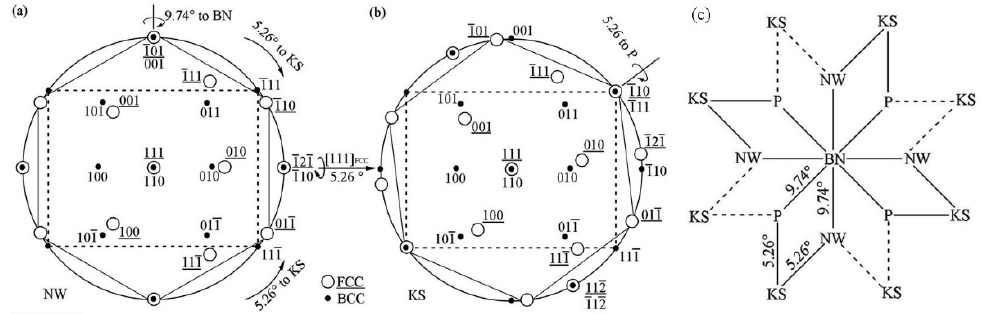
Figure 6. Schematic diagram illustrating the stereographic projection of NW OR ( a ) and KS OR ( b ),